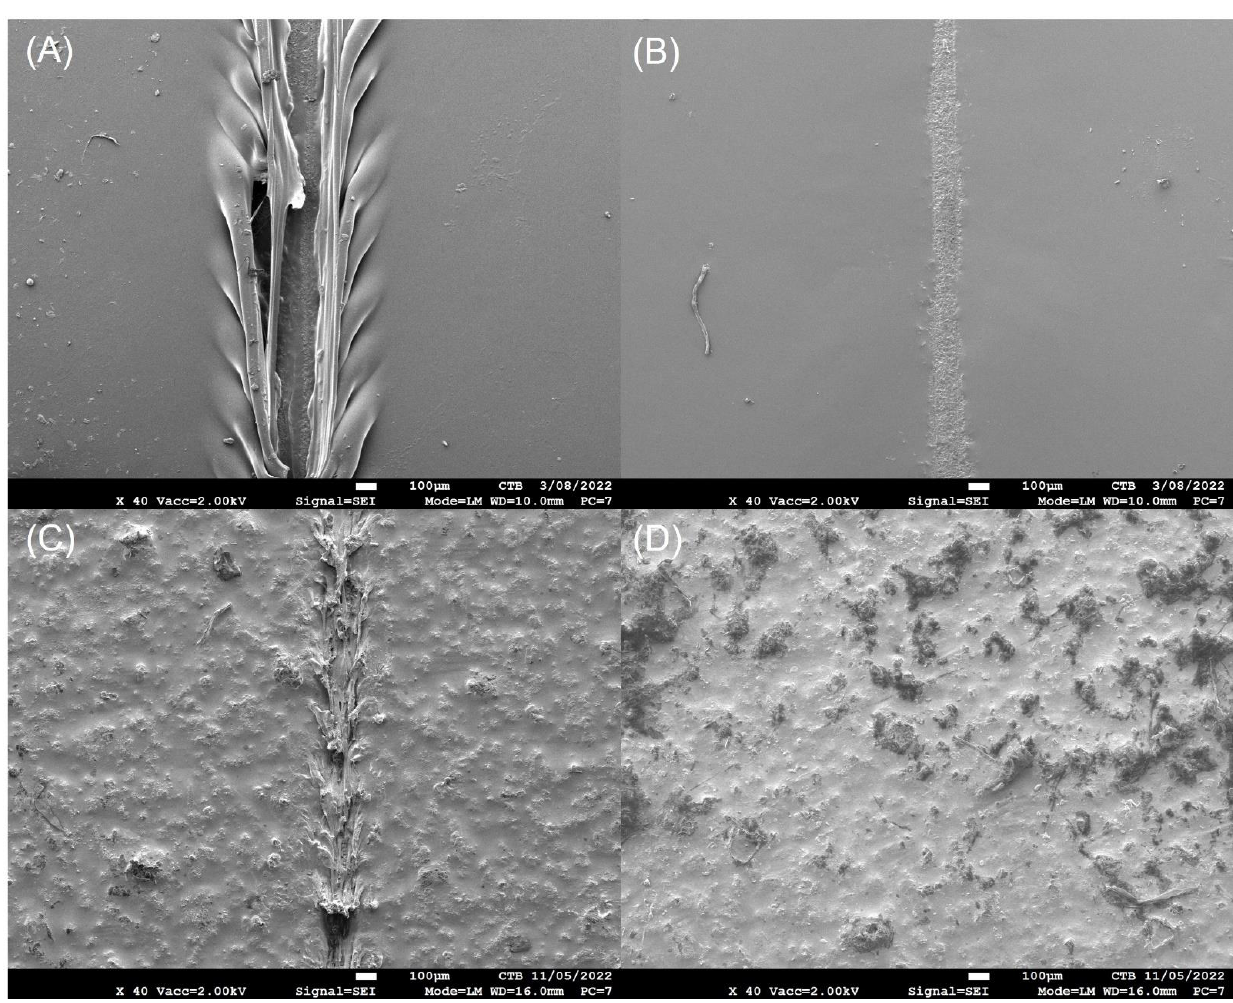
Figure 3. SEM analysis of scratched surfaces of control PU before ( A ) and after healing ( B ) and healable PU before ( C ) and after healing ( D ). Healing occurred for 30 min at 90 ◦ C.